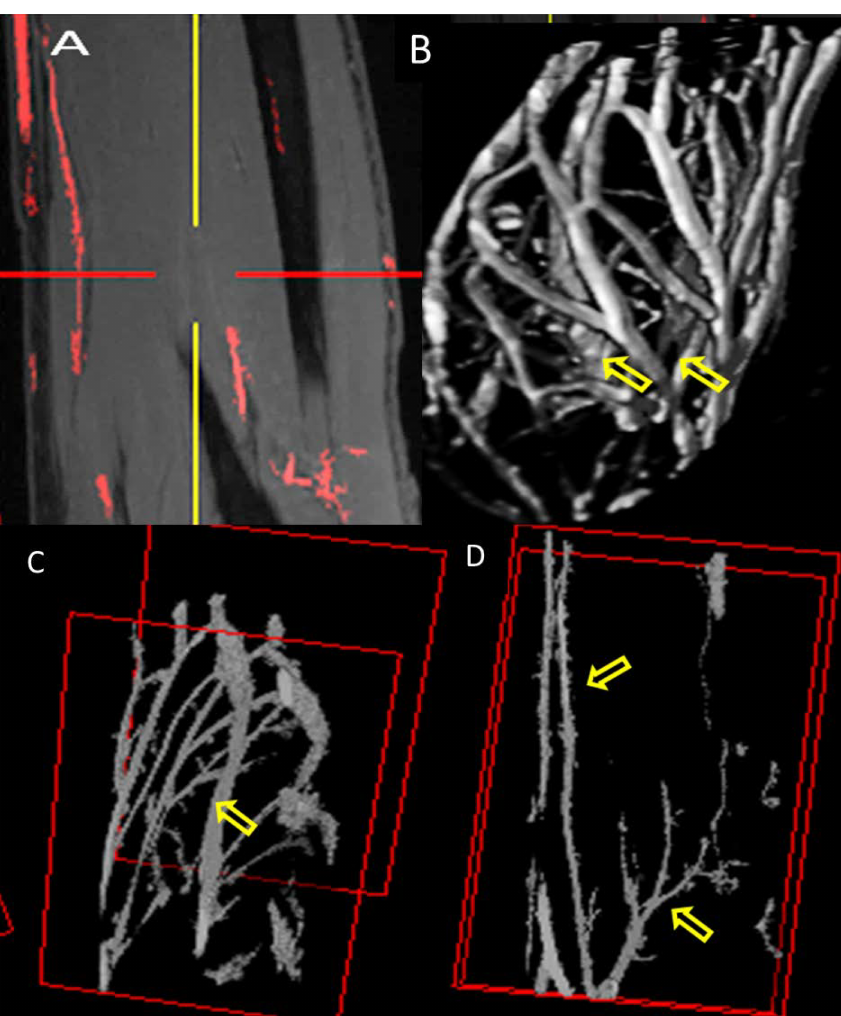
Fig 9. 7T Vasculature Segmentation: A representscoronal image as an exampleof paint grows segmentation method using T1 VIBE images. B displaysforearm vasculature segmentation [3D view] showingbrachial artery and its branches [arrows] as well as venaecomitans and superficial arteriovenous networks. C shows completeulnar artery [arrow] and D representsradial [arrow] and brachialbifurcation [arrow] in the